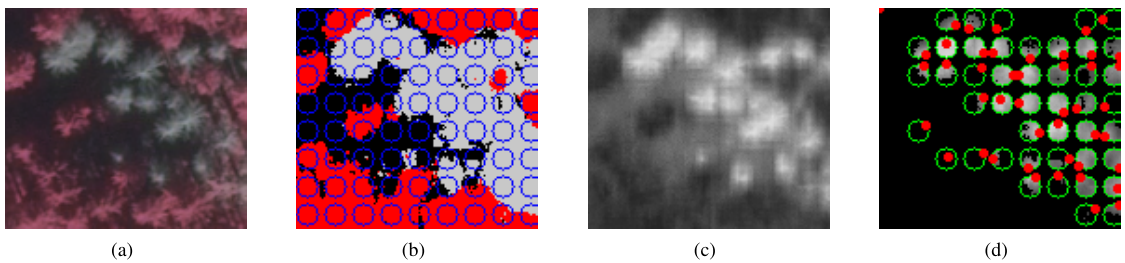
Figure 3. Selecting locations for initializing the level set segmentation. (a) Input image. (b) Result of candidate region detection covered by circles which indicate candidate starting locations. (c) Pixel-level dead tree probabilities of image points from intensity prior. (d) Intersection of candidate circles and dead tree cluster from candidate region detection. Red dots mark chosen starting locations for segmentation, grayscale values depict dead tree probability as in (c).